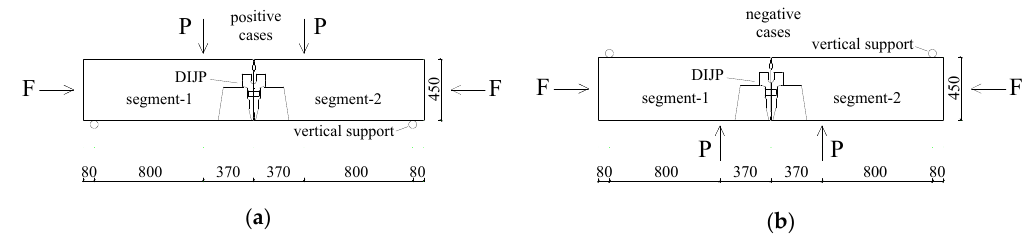
Figure 7. Exerted loads: ( a ) positive case; ( b ) negative case.